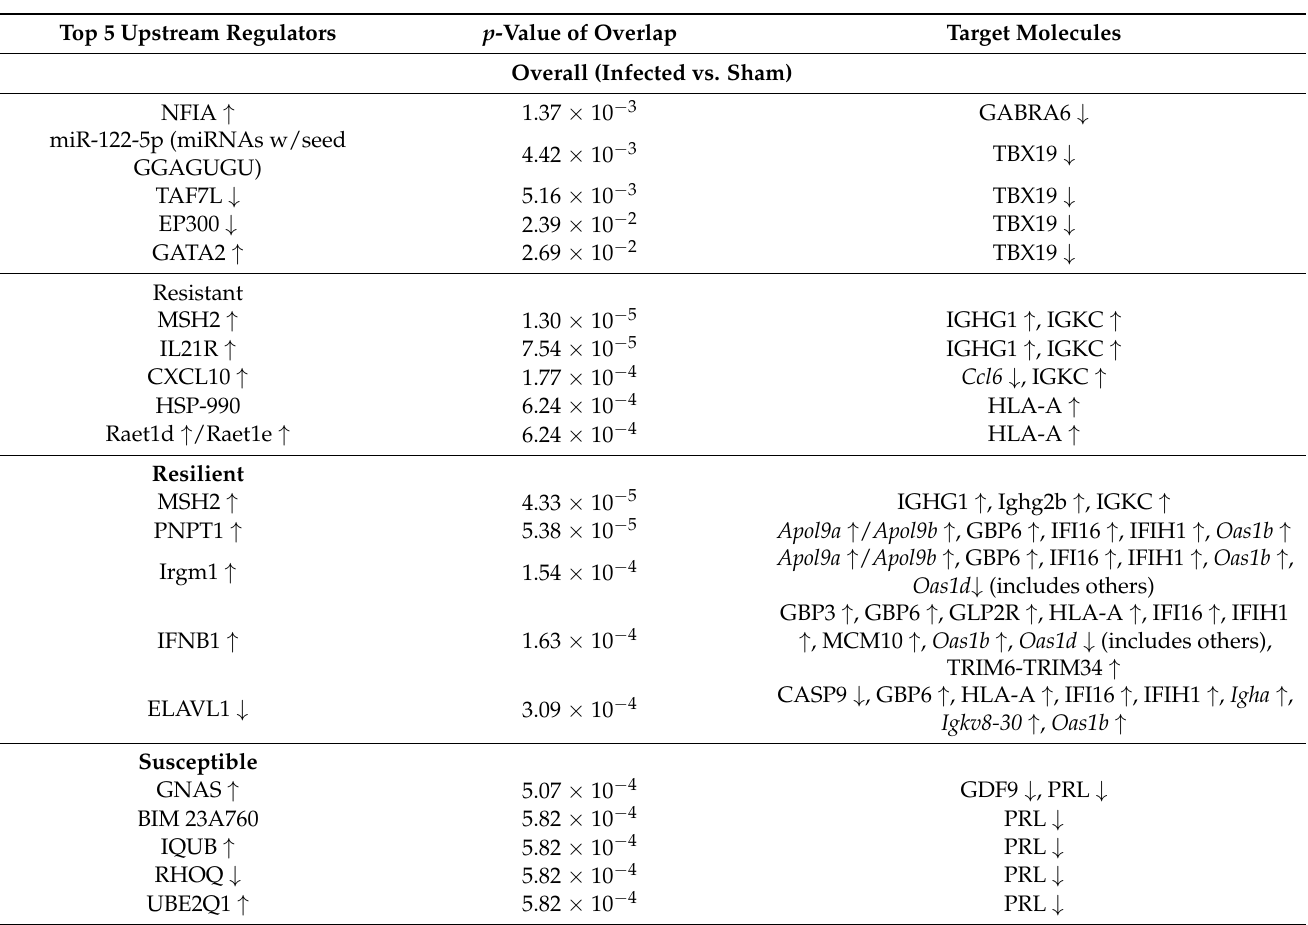
Table 2. Top 5 upstream regulators for each category described in this study, along with their respective p -values and target molecules (genes and complexes). Here, “ p -value of overlap” indicates the significance of overlap between genes of this dataset and those influenced by the upstream regulator, using Fisher’s exact t -test [37]. Arrows indicate the direction of gene expression (increased or decreased) in infected versus uninfected mice, based on the averaged expression values for strains included in each response. Additional information for these regulators and molecules, including descriptions and chromosomal locations, is found in Supplementary Table